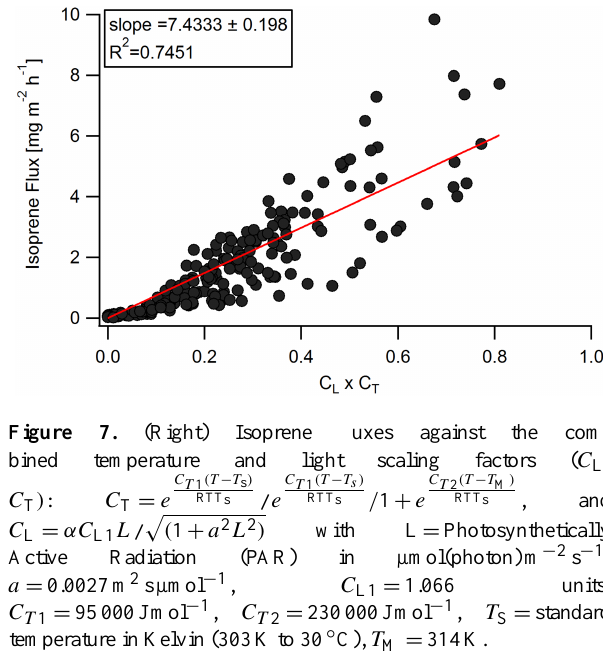
C T 1 = 95000Jmol − 1 , C T 2 = 230000Jmol − 1 , T S = standard temperature in Kelvin (303K to 30 ◦ C), T M =